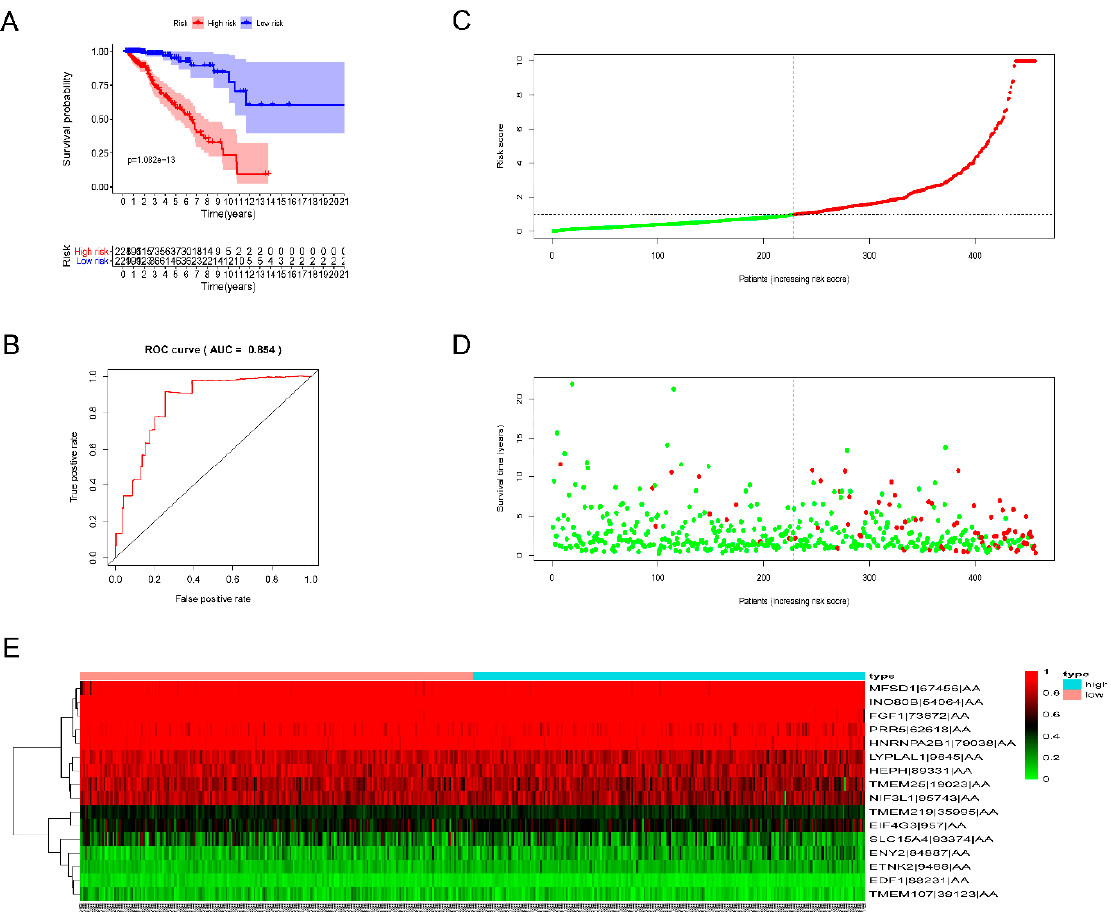
Figure 5. Analysis of the PS–alternate acceptor site (AA). The 16 prognosis-associated events of AA